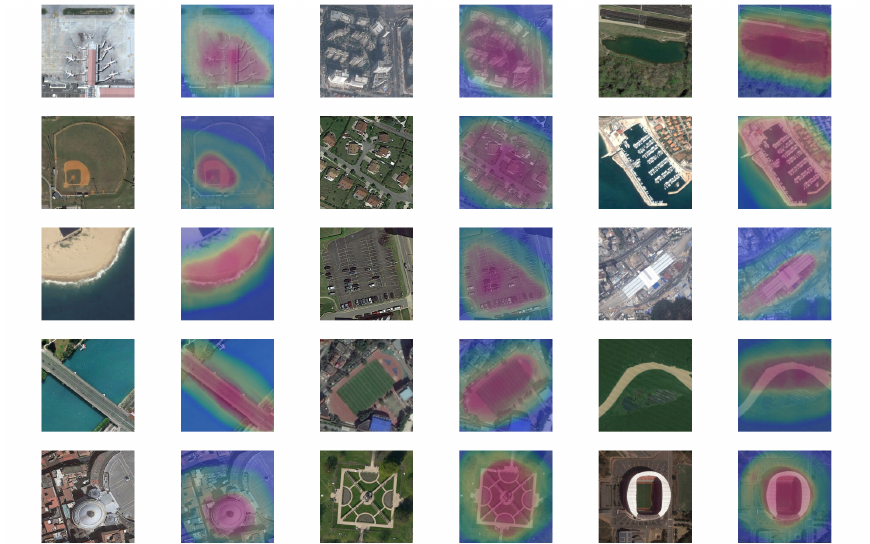
Figure 20. The CAM method visualization results of our model on AID